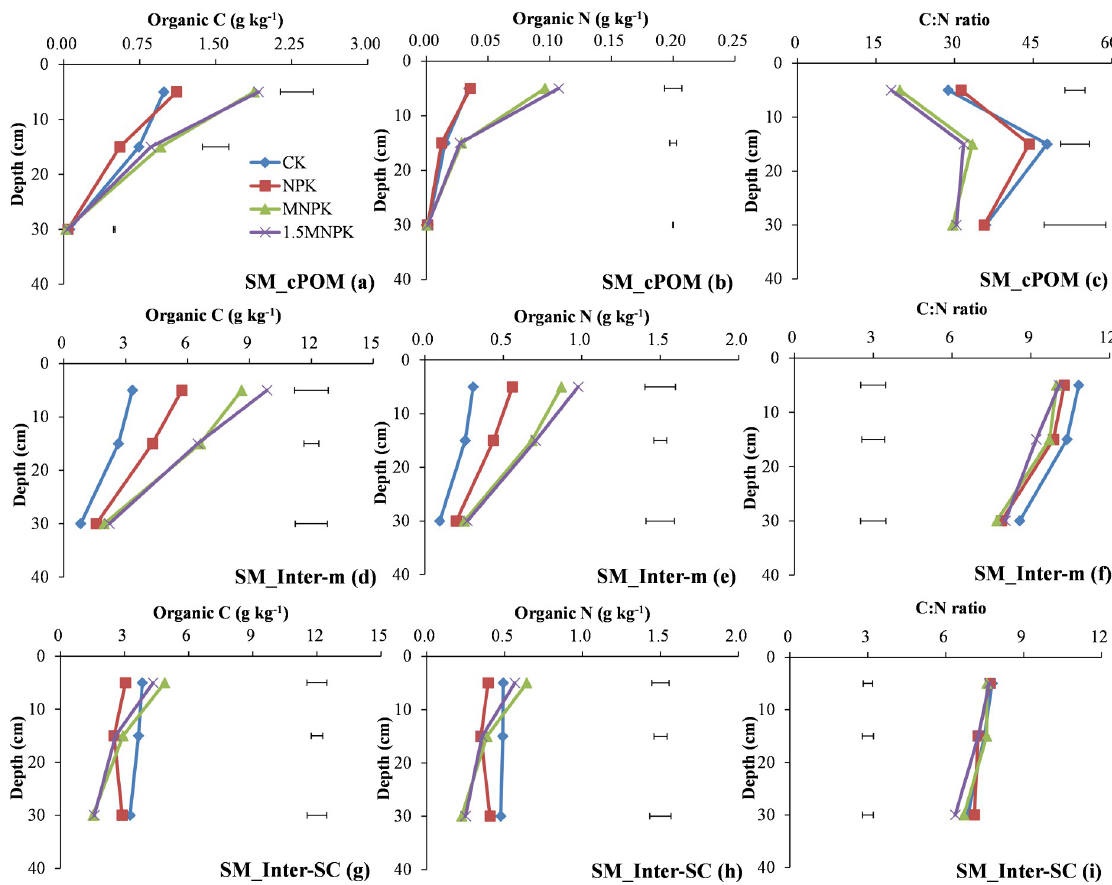
Fig 4. Change in organic C and N concentrations and their C/N ratios in small macroaggregate (SM) fractions of control (CK), chemical fertilizer (NPK), and combined manure and chemical fertilizer (MNPK, 1.5MNPK) treatments in the top 40 cm of the soil profile. Values at each soil depth are the mean of three replicates. The horizontal lines denote the least significant difference values at the 0.05 level (LSD0.05) among different treatments at each soil depth. Symbols of aggregate fractions: see Fig 1